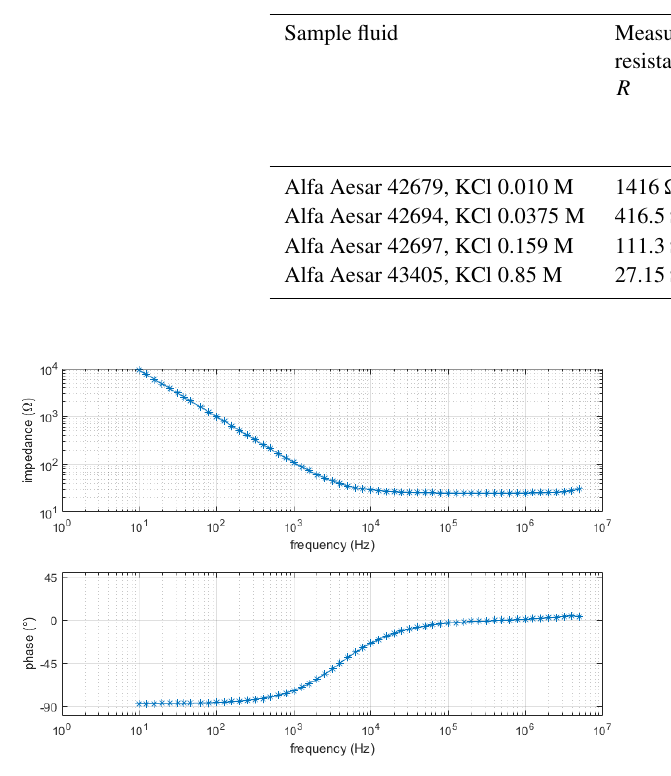
Figure 9. Bode diagram of electrical conductivity measurement us- ing Consort B562 calibration solution 1 M KCl.